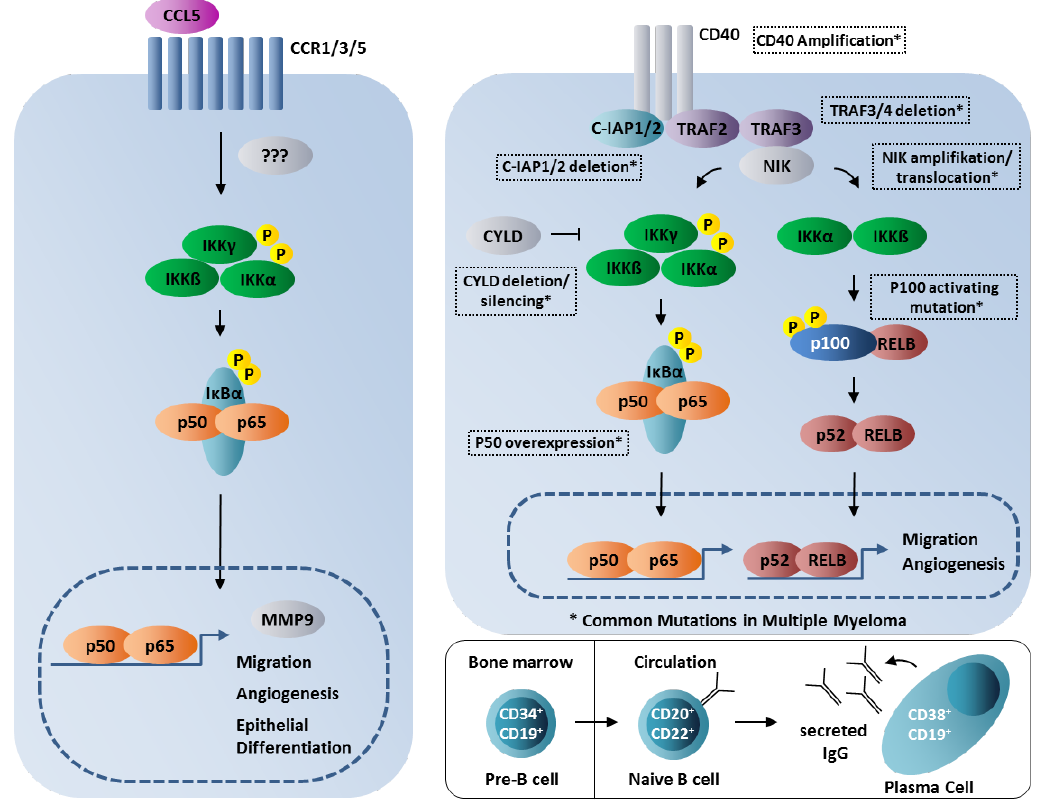
Figure 1. The role of NF- κ B signaling pathways in cancer stem cells. Cancer stem cells (CSCs) from ovarian cancers could show CCL5-dependent activation of NF- κ B p65-mediating MMP9-expression, migration, angiogenesis, and epithelial di ff erentiation of CSCs [22] (left panel). Canonical and non-canonical NF- κ B signaling in CSCs from multiple myeloma including commonly known mutations, which generate constitutive NF- κ B-activity. Mutations are shown in boxes (right upper panel, modified from [23]). Development of plasma cells from pre-B cells in the bone marrow (right lower panel). Note that most authors think that NF- κ B mutations are acquired during naive B cell to plasma cell di ff erentiation, although high levels of pre-B cells in multiple myeloma patients might hint to some mutations already in present in the bone